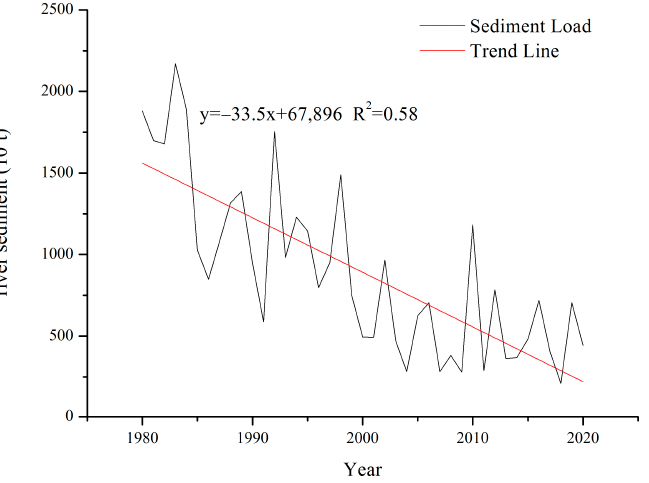
Figure 7. Sum of the annual sediment load in the Poyang Lake estuary during 1980–2020.